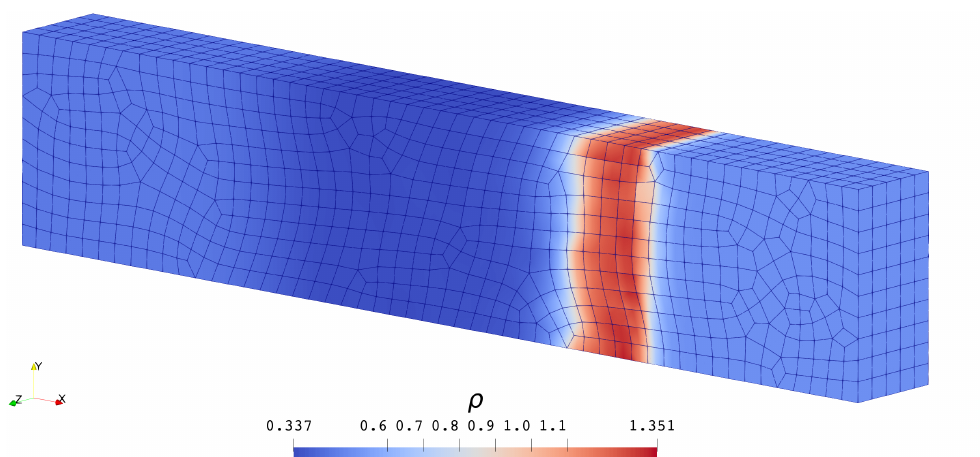
Figure 14. Third-order solution of ρ ( t = 0.6 ) in Problem